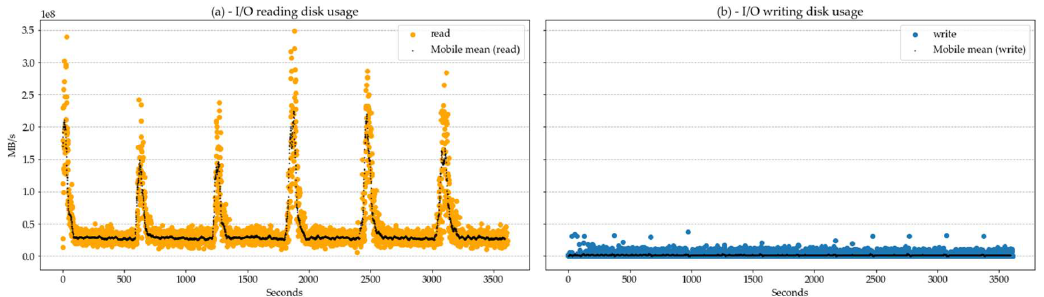
Figure 9. Disk usage in reading ( a ) and writing ( b ) during the test case B with 500 concurrent users.